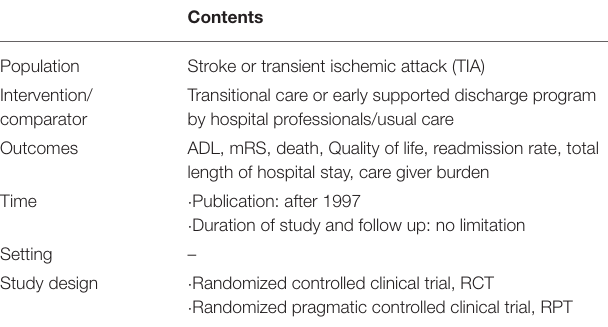
TABLE 2 | Strategy for study